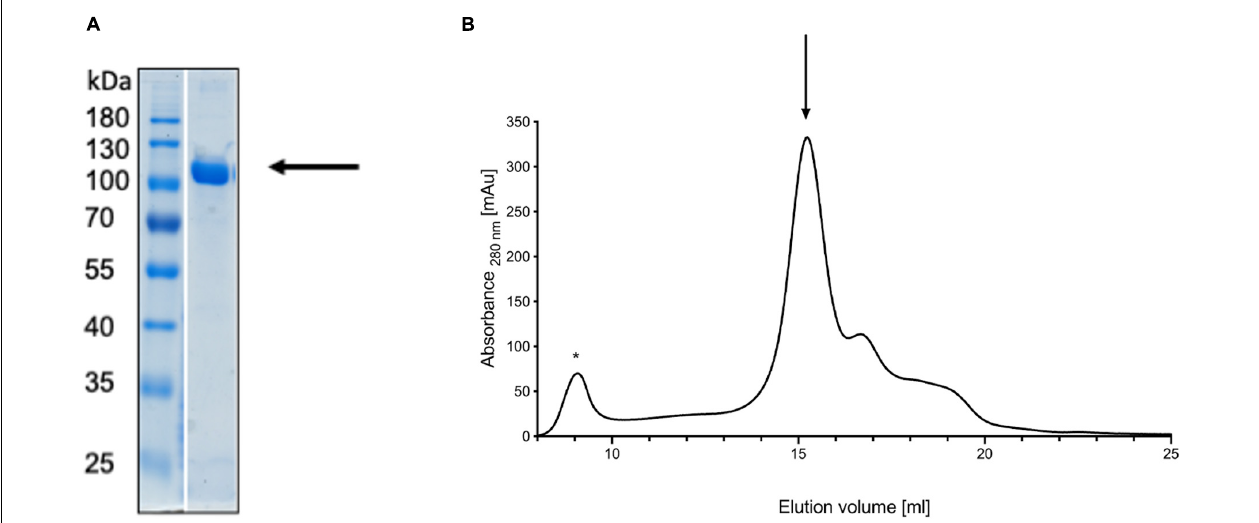
FIGURE 2 | Denaturing gel of refolded pro-HlyA (indicated by an arrow) (A) and the corresponding SEC chromatogram (B) . The void volume is indicated by an asterisk and the elution peak of pro-HlyA by an arrow. The SDS-PAGE gel was stained with Coomassie Brilliant